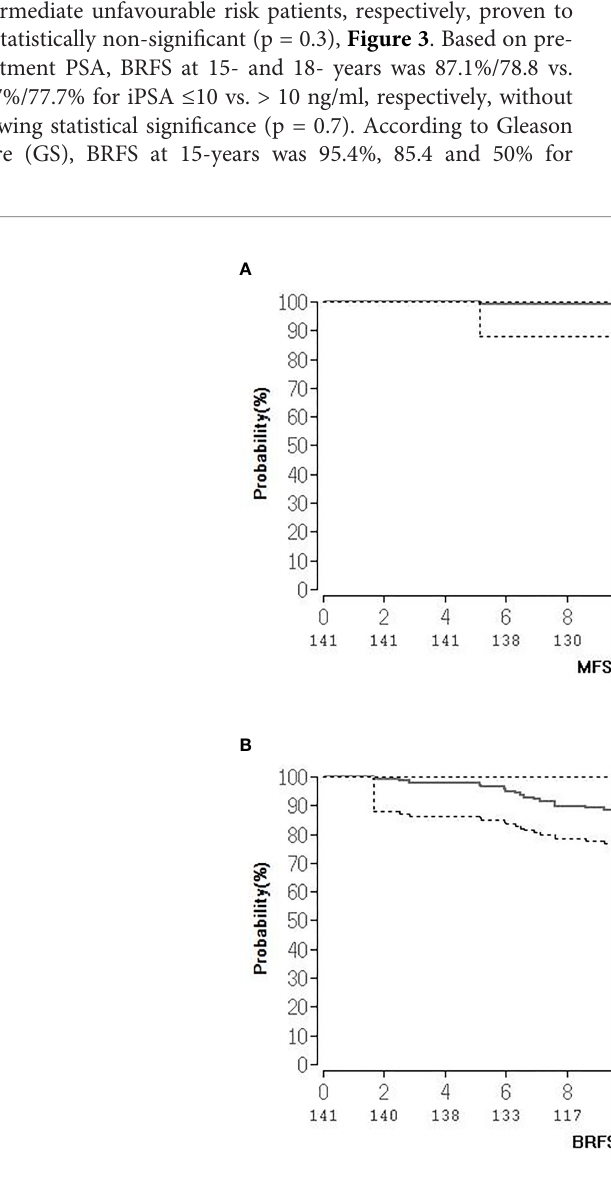
FIGURE 1 | (A, B) Kaplan-Meier survival curves of BRFS and